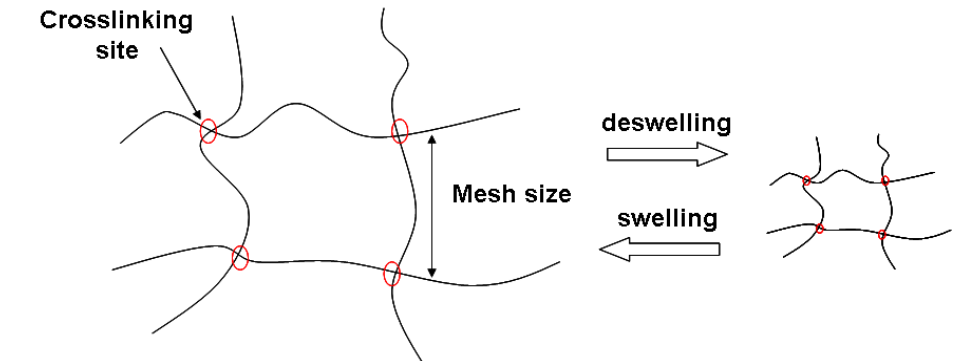
Schematic structure of a tetrafunctional polymer network